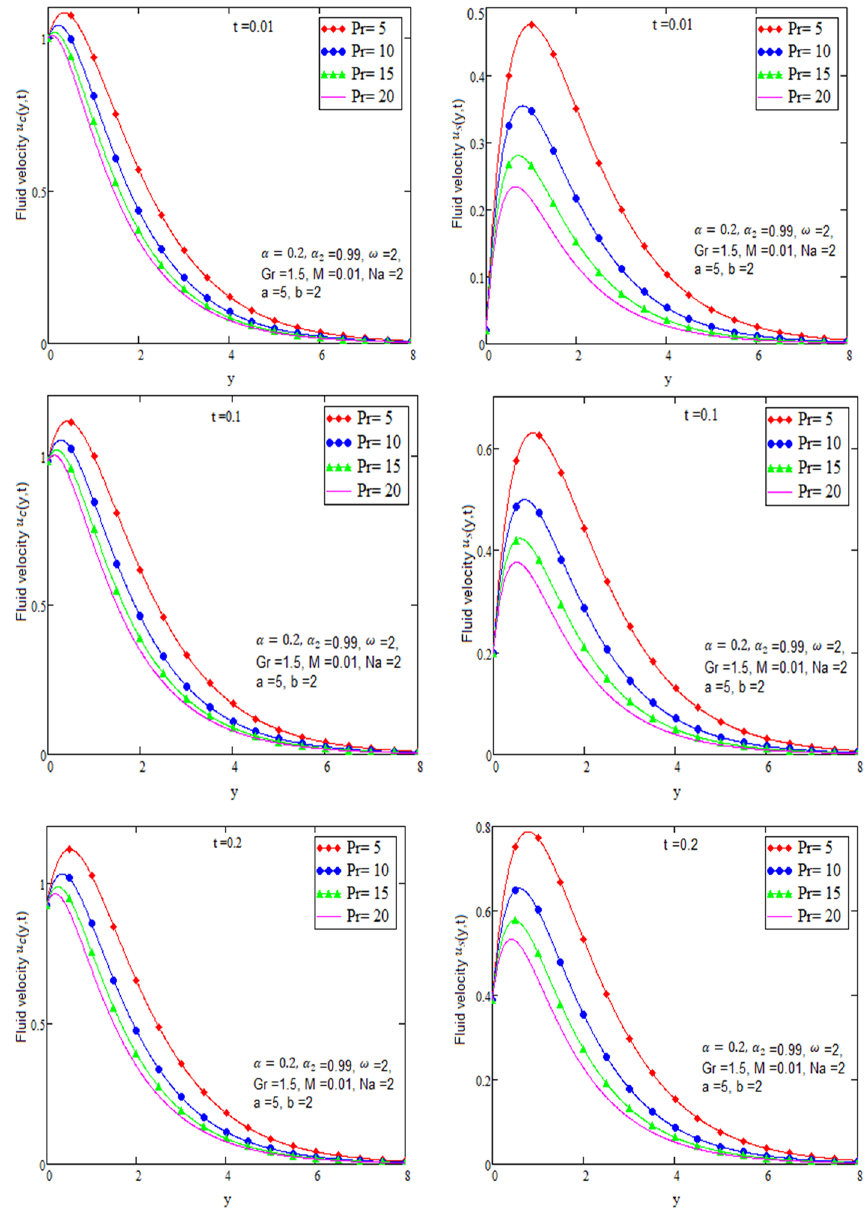
Figure 6. Graph of velocity for different value of Prandtl number Pr in case of cosine and sine